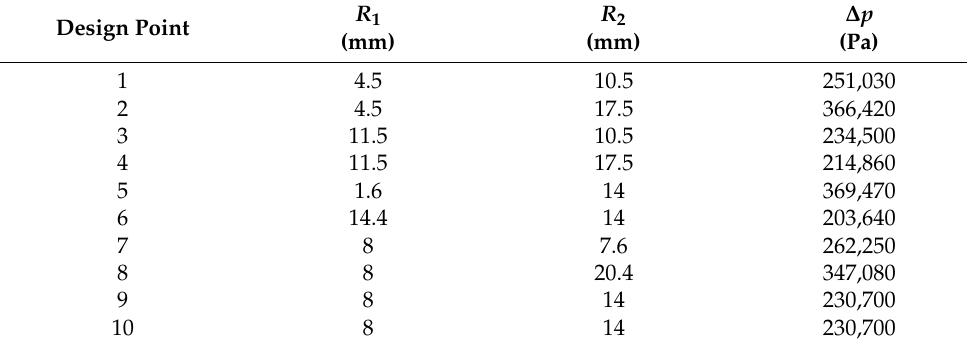
Table 4. Design points with pressure drop.